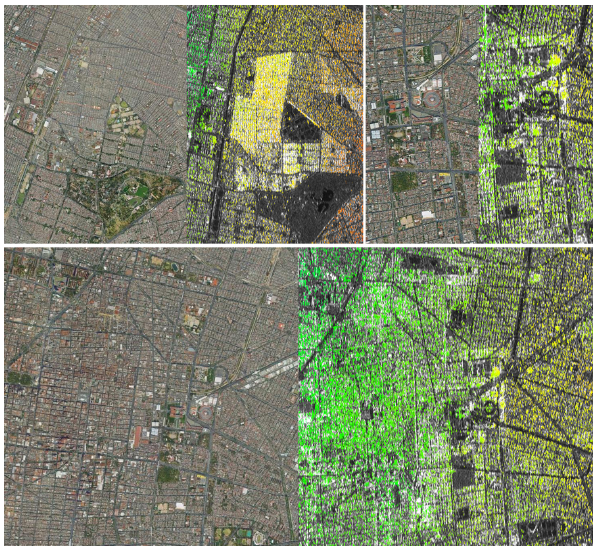
Figure 2. Three examples of the sample density of Cousin Persis- tent Scatterers (CPSs) achieved in the urban area of the processed burst. Each example shows an orthoimage and the SAR amplitude image of the same area with the CPSs processed with the PSI tech- nique.